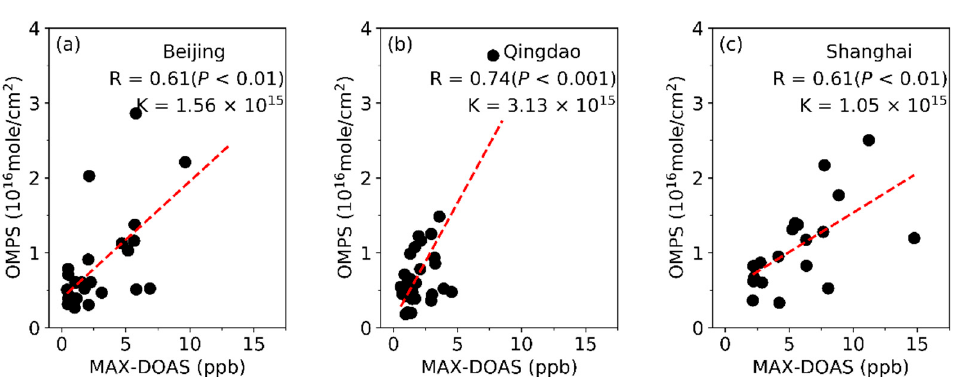
Figure 1. Scatter plot of Ozone Mapping and Profiling Suite (OMPS) observed tropospheric formaldehyde (HCHO) vertical column concentrations (VCDs) with Multi-Axis Differential Optical Absorption Spectroscopy (MAX-DOAS) measured surface concentrations of HCHO at ( a ) Beijing, ( b ) Qingdao and ( c ) Shanghai sites (daily data from five weeks before 23 January 2020 to five weeks after 23 January 2020).